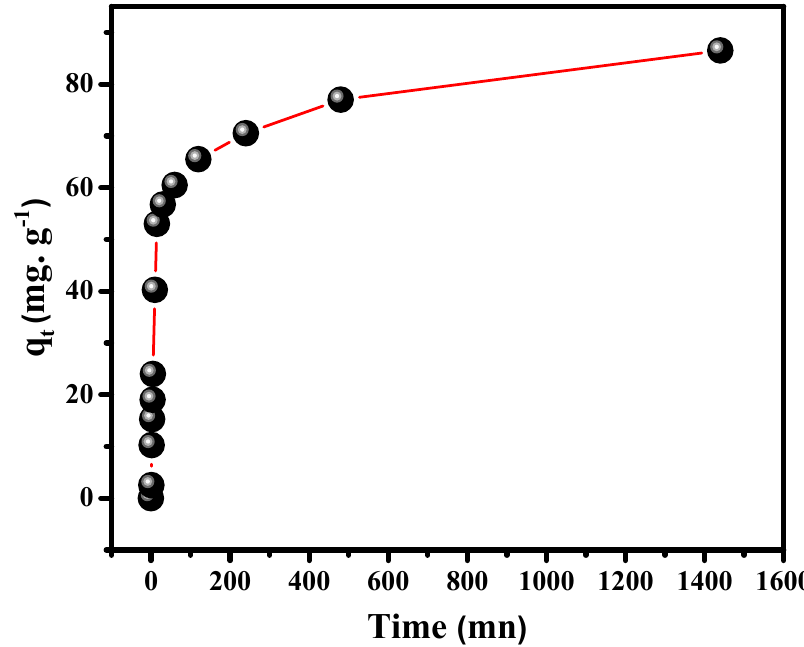
Figure 5. Impact of interaction time on the Cu (II) ions sorption onto MgY 2 O 4 @g-C 3 N 4 .